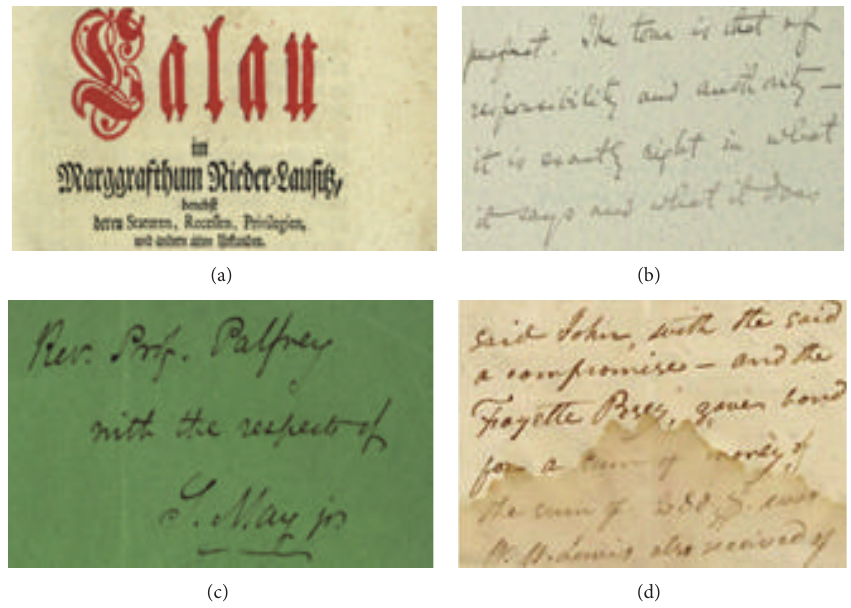
Figure 3: Images taken from the collections of (a) DIBCO 2009, (b) H-DIBCO 2010, (c) DIBCO 2011, and (d) H-DIBCO 2012.